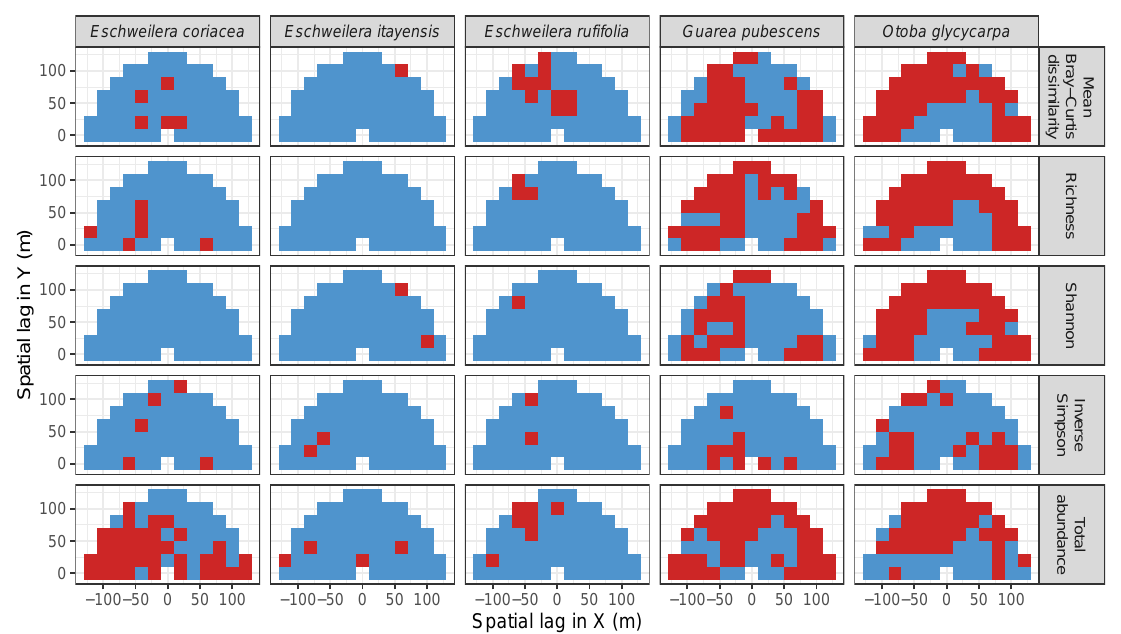
Figure A5. Statistical significance (red: P ≤ 0.05; blue: P > 0.05) of the codispersion coefficients calculated between measures of diversity and total basal area of the five focal tree species in 20 × 20-m subplots in the 25-ha Amacayacu plot (Figure 17). Statistical significance was determined by comparing observed codispersion at each spatial lag with a distribution of 199 spatial randomizations of a CSR null model.